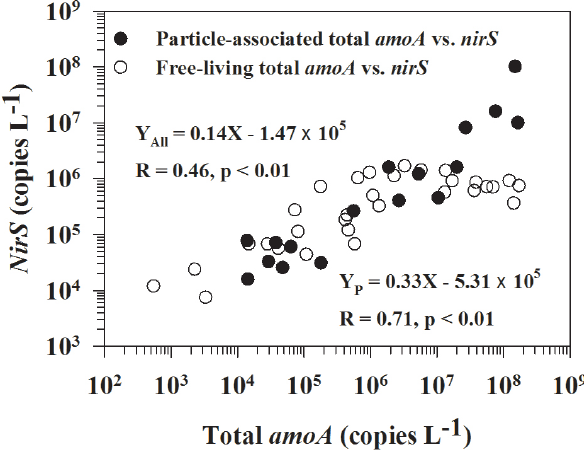
Fig. 10. Analysis of relationships between the total amoA (sum of β -AOB and AOA amoA ) and nirS gene